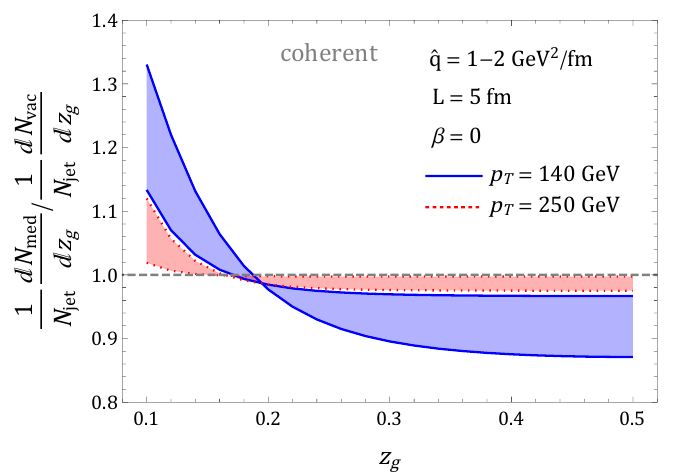
Figure 2. (Color online) The ratio of normalised z g -distributions in Pb-Pb and pp collisions for p = 140 GeV (full lines) and p = 250 GeV (dashed lines). The shaded area between the pairs of T T curves accounts for the variation of ^ q